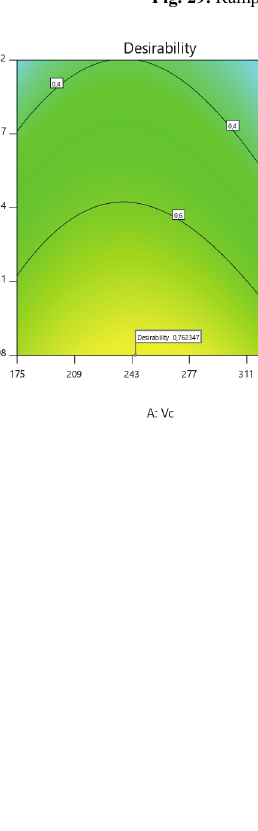
Fig. 29. Ramp function graph for cutting force components and Ra, Fz, Pc and MRR combined optimization